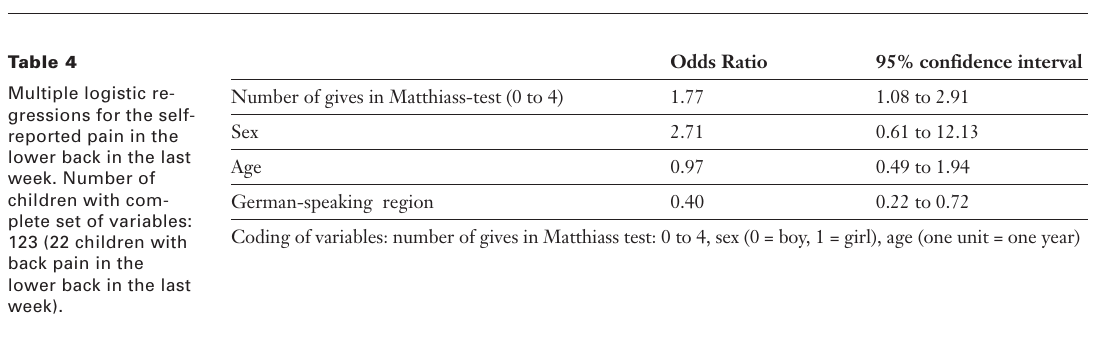
Multiple logistic regressions for the self-reported pain in the upper back in the last week. Number of children with com- plete set of variables: 123 (28 children with pain in the upper back in the last week).